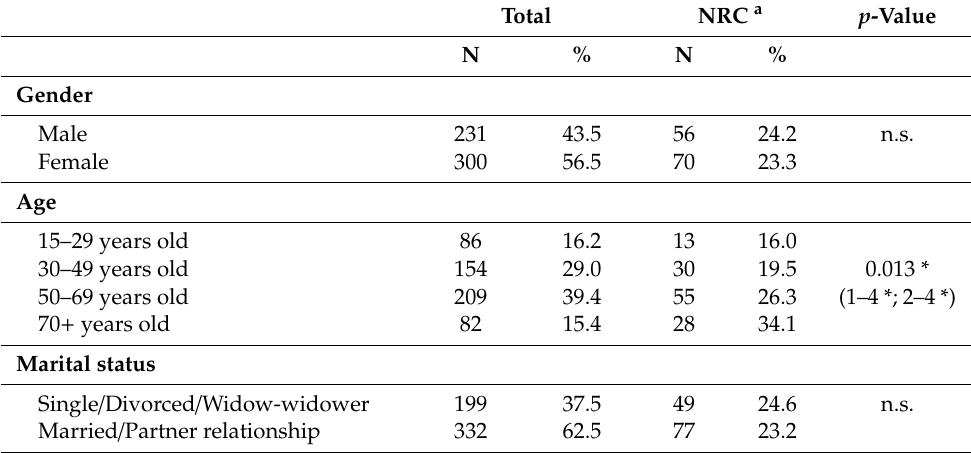
Table 1. Description of the study population, total and by religiosity / spirituality (R /